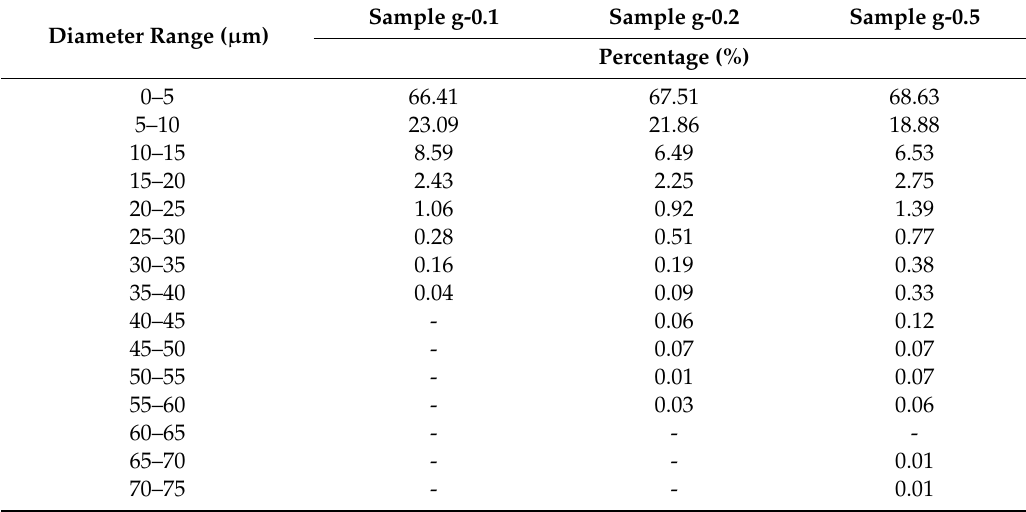
Table 2. Flakes’ dimension distribution inside the cataphoretic coatings. Diameter Range ( µ